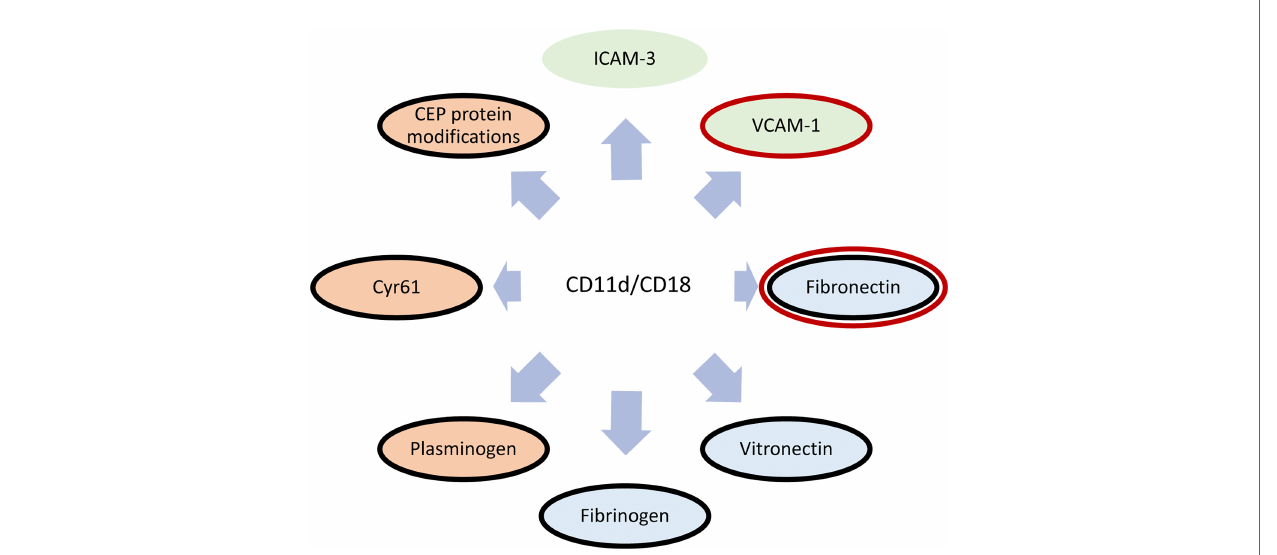
FIGURE 3 | Diagram of known CD11d/CD18 ligands. Cellular receptors are shaded green, extracellular matrix proteins are blue, and proteins/protein modi fi cations prevalent within the ECM during in fl ammation are red (51, 68). Shared ligand speci fi cities with CD49d/CD29 is denoted in a red outline (70), while shared ligand speci fi cities with CD11b/CD18 is outlined in black